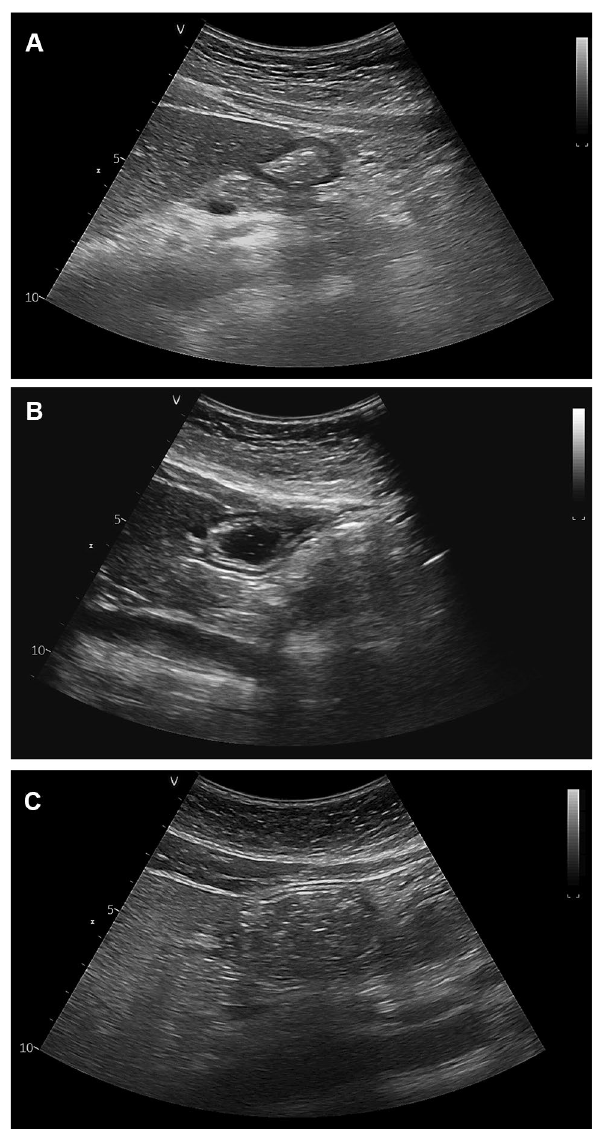
Figure 2. Ultrasound image of the gastric antrum in the epigastric area obtained in a sagittal or parasagittal plane according to gastric contents. The empty antrum (grade 0) is presented ( A ) in the right lateral decubitus, The antrum with minimal, insignificant amount of fluid (grade 1) appears ( B ) in the right lateral decubitus; The antrum with significant fluid content (grade 2) is detectable ( C ) in the right lateral decubitus.